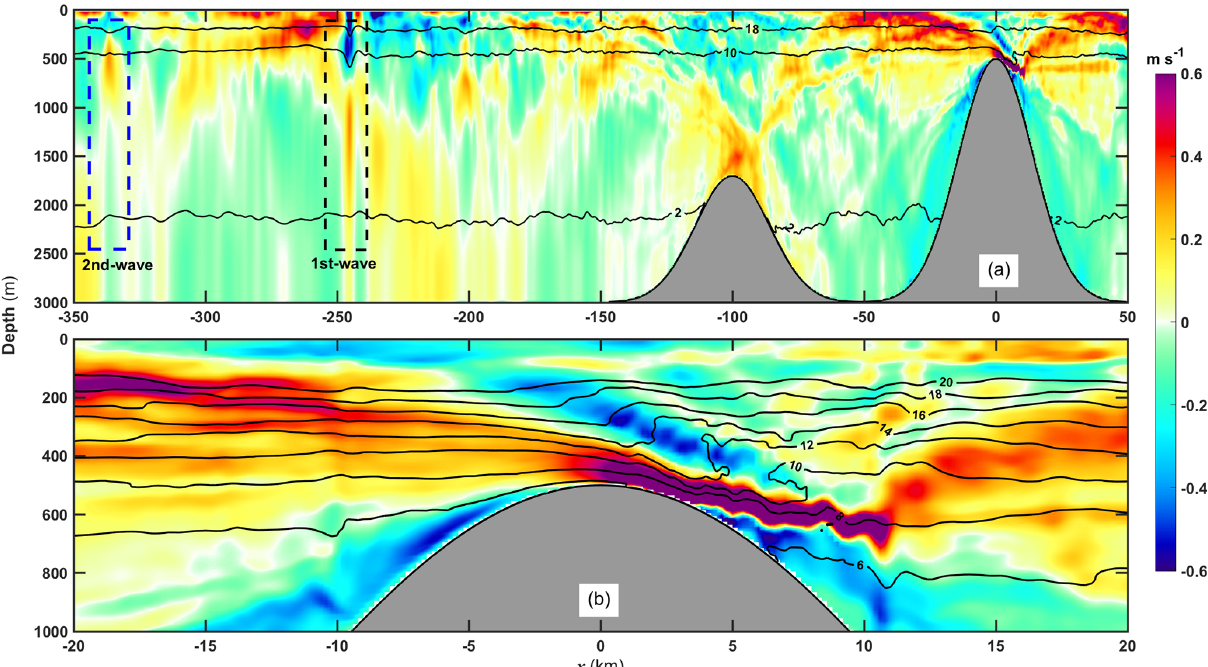
Figure 18. Distributions of horizontal baroclinic velocity with temperature ( ◦ C) contours for the western far field (a) and source field (b) when the maximum eastward tidal current at the east ridge reaches the end of ebb on the sixth day; the blue (black) dashed box means the second- mode (first-mode) ISW